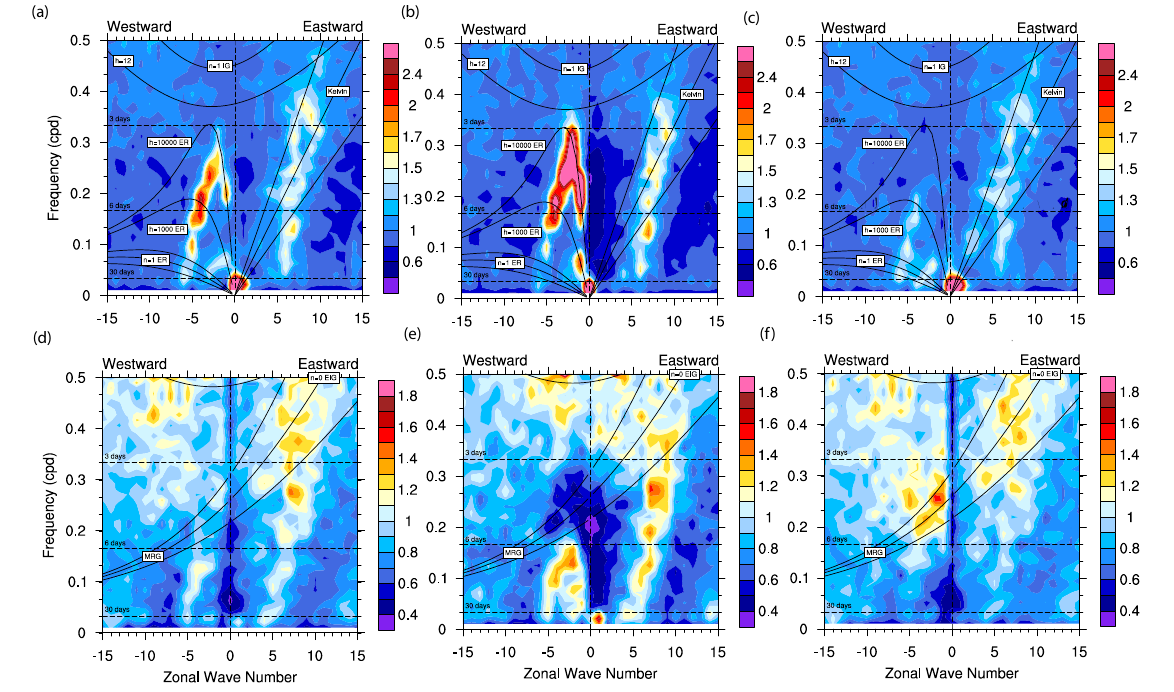
Figure 6. Wavenumber-frequency spectrum of the 200 hPa zonal wind field associated with the rota- tional modes. Panels ( a – c ) refer to the symmetric part, while panels ( d – f ) refer to the antisymmetric part. The full spectrum of vertical modes is presented in panels ( a , d ), the barotropic component of the corresponding parts is displayed in panels ( b , e ), and the baroclinic component is illustrated in panels ( c , f ).